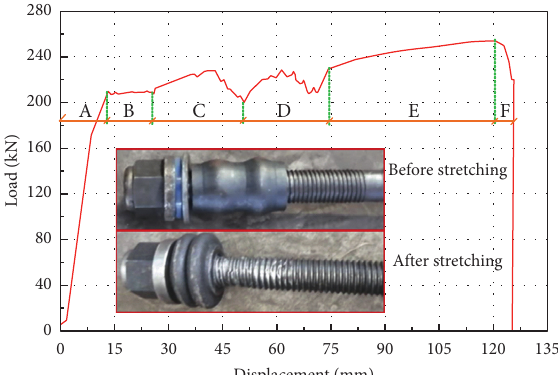
Figure 15: Tensile test curve of the double-bubble yielding bolt. A: elastic deformation section of the yielding bolt; B: yielding section of the bolt rod; C: deformation yield section of bubble 1; D: deformation yield section of bubble 2; E: reinforcement deformation section of the bolt rod; F: fracture section of the bolt